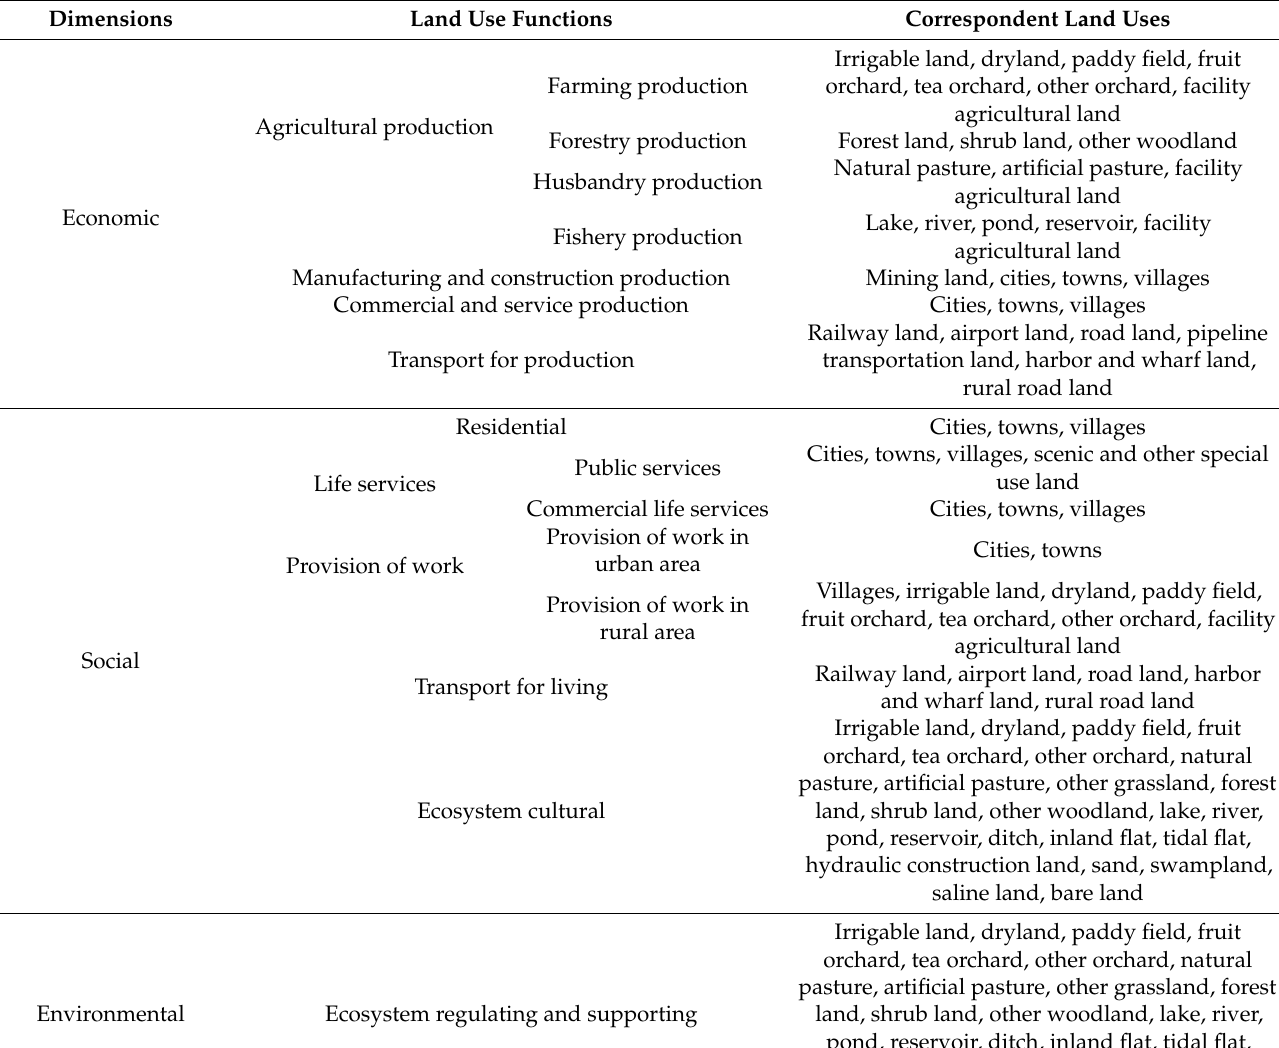
Table 1. LUFs and corresponding land uses in the second national land use survey of